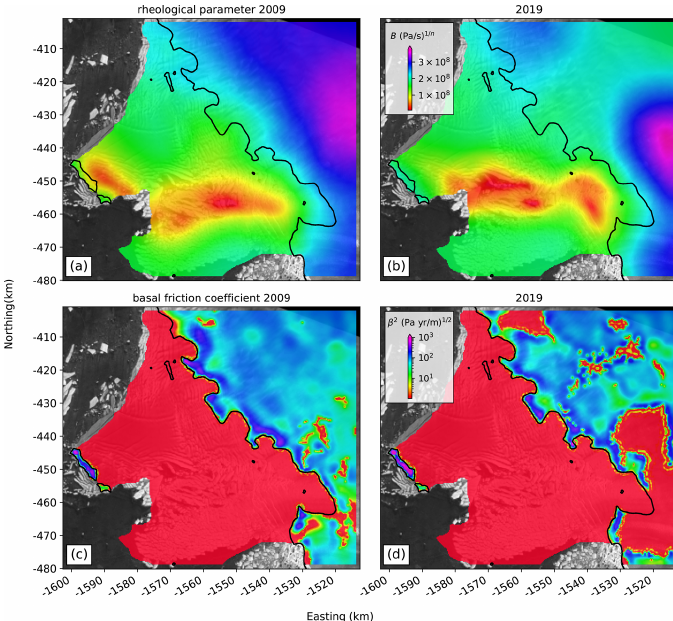
Figure A2. Inferred fields of the rheological parameter and the basal friction coefficient from the iterative inversion using both the MEa- SUREs and our Landsat-8 velocity field. Note (i) the rheological weakening of the shear margin between the Eastern Ice Shelf and the Western Glacier Tongue, (ii) the misrepresented rheological strengthening of the shear zone upstream of the pinning point that is clearly absent in visible satellite imagery, (iii) high values of the basal friction coefficient at the pinning point, and (iv) very low friction values underneath Thwaites Glacier’s main trunk that suggest distributed thawed bed properties. Table A1. Symbols used in this